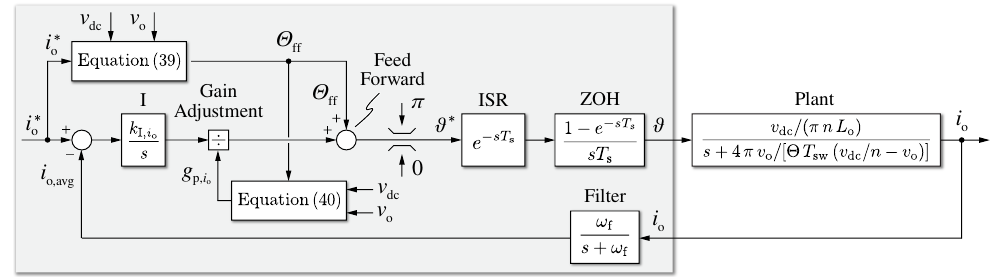
Figure 10. Detailed block diagram of the DC/DC output current ( i o ) control loop.